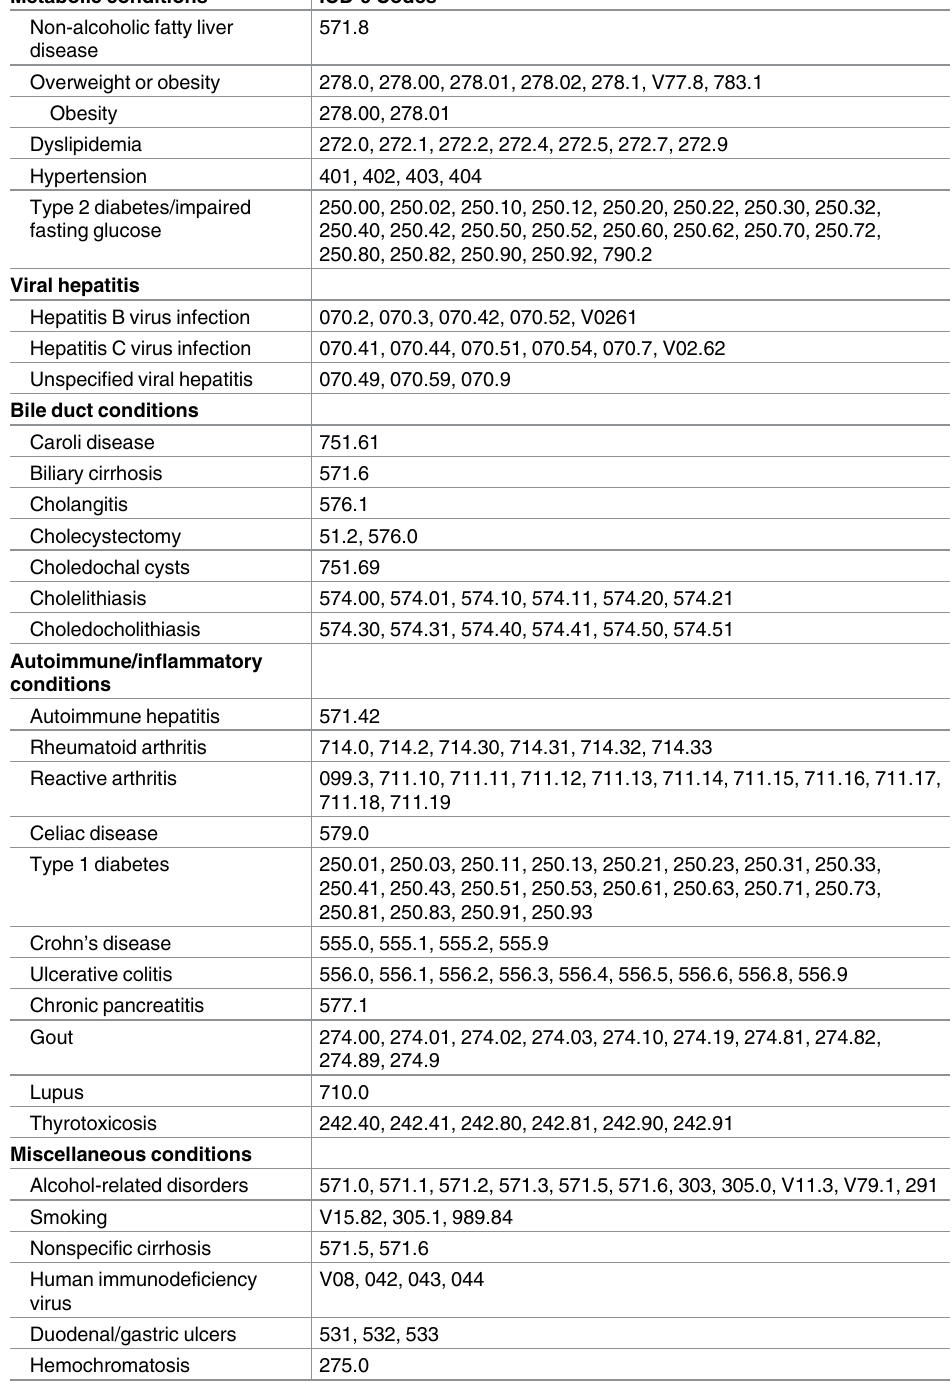
Table 1. International Classification of Diseases,ninth edition codes for preexisting medical condi- tions and risk factors for